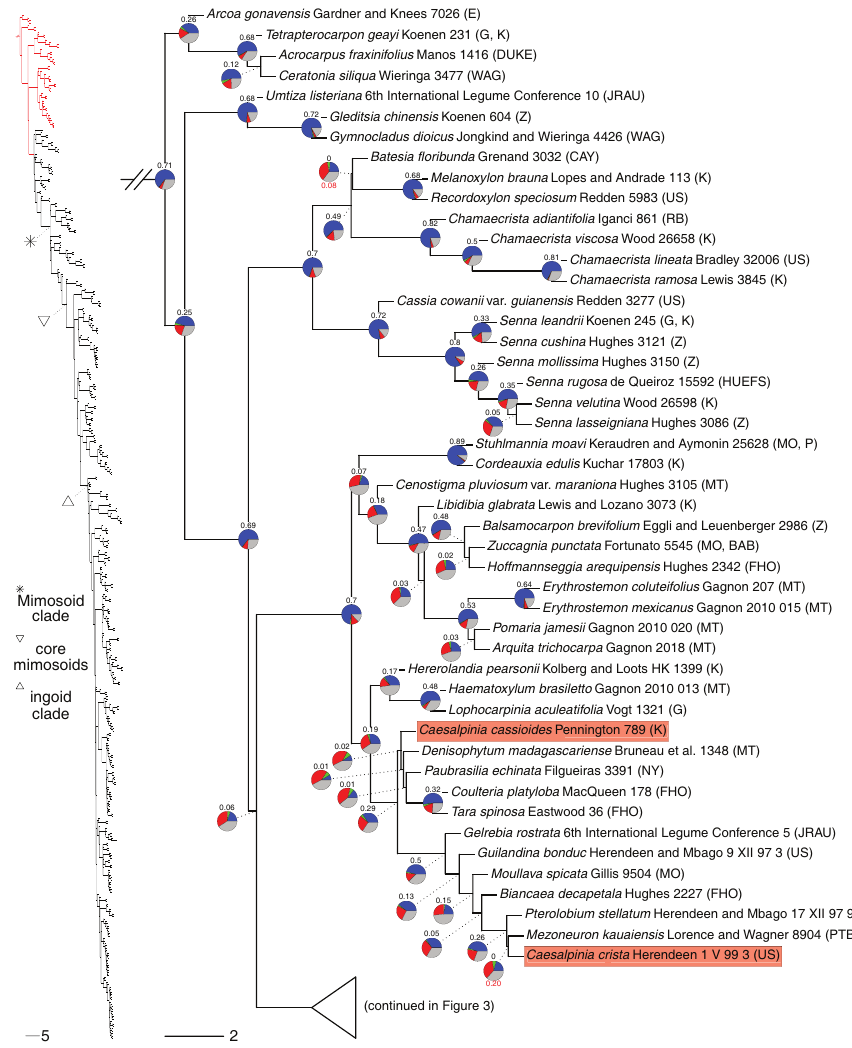
Figure 2. Phylogeny of Caesalpinioideae, part 1 (continued in Figs 3–12). Left part of figure shows complete Caesalpinioideae phylogeny with highlighted in red the part shown in detail on the right. Depicted phylog- eny is the ASTRAL (Zhang et al. 2018) phylogeny based on 821 single-copy nuclear gene trees, with branch lengths expressed in coalescent units and terminal branches assigned an arbitrary uniform length for visual clarity. Genera resolved as (potentially) non-monophyletic are highlighted and clades recognised by Koenen et al. (2020b) are labelled. Support for relationships is based on gene tree conflict: pie charts show the fractions of supporting and conflicting gene trees per node calculated using PhyParts (Smith et al. 2015), with blue representing supporting gene trees, green gene trees supporting the most common alternative topology, red gene trees supporting further alternative topologies and grey gene trees uninformative for this node. Numbers above nodes are Extended Quadripartition Internode Certainty scores calculated with QuartetScores (Zhou et al. 2020). Numbers below nodes are the outcome of ASTRAL’s polytomy test (Sayyari and Mirarab 2018), which tests for each node whether the polytomy null model can be rejected. Only non-significant (i.e. > 0.05) scores are shown, i.e. only for nodes that are better regarded as polytomies according to the